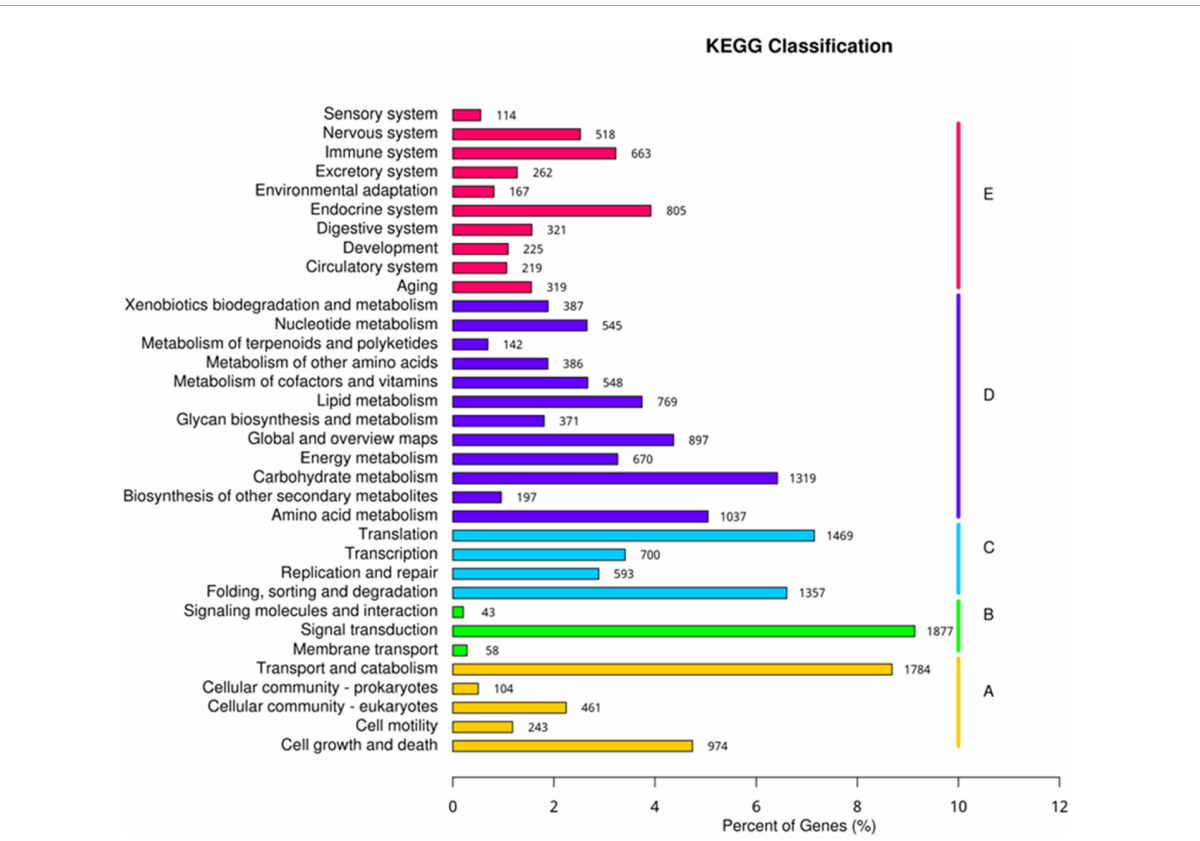
FIGURE8 Kyoto encyclopedia of genes and genomes (KEGG) classification of genes expressed in different processes.